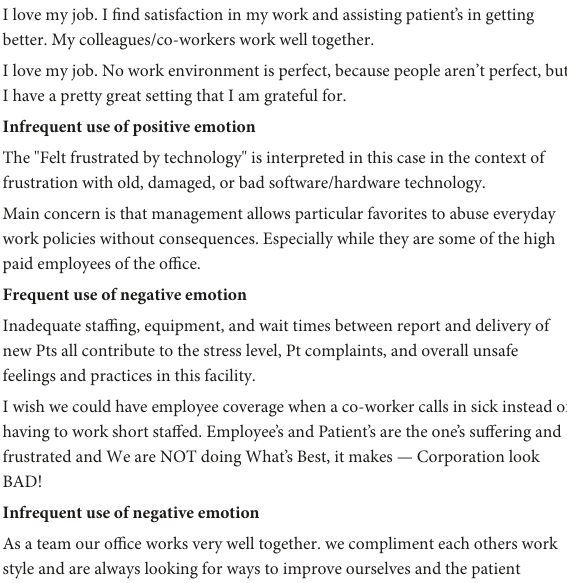
TABLE 3 Representative comments from the frequent and infrequent use of the linguistic categories. Frequent use of positive